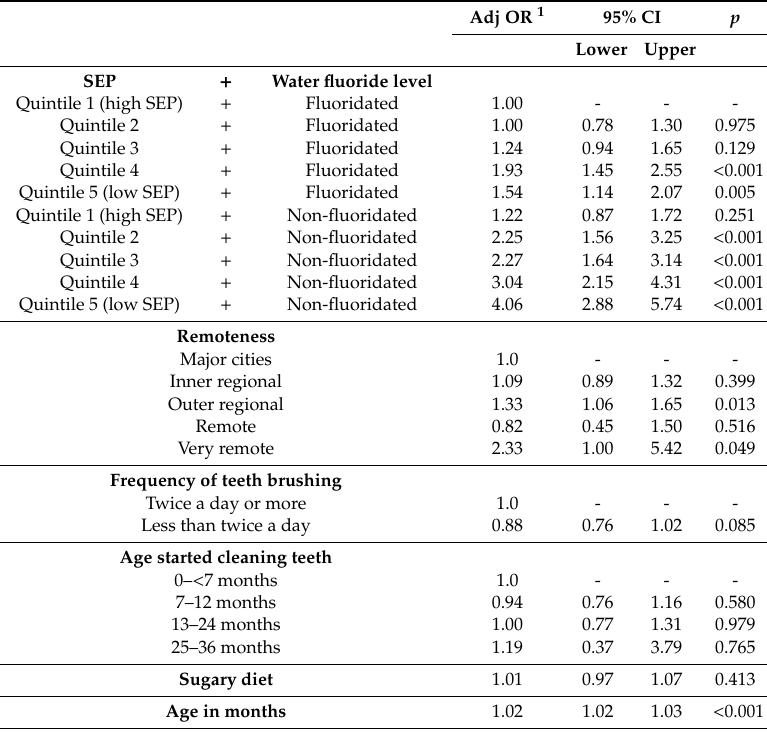
Table 3. Findings of multilevel mixed-e ff ects logistic regression: Association with dental caries including SEP and fluoride